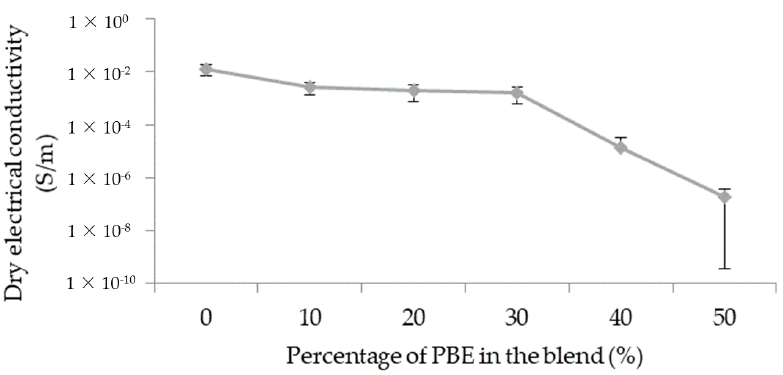
Figure 6. Influence of the proportion by weight of PBE on the electrical property of the PA6.6 3CNT /PBE blends.